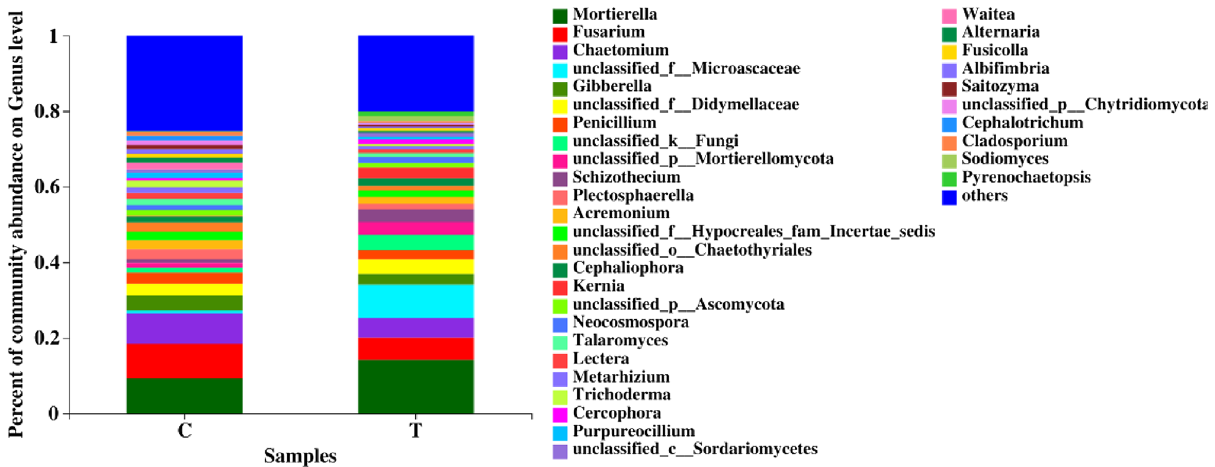
Figure 5. Fungal community composition on genus level at different